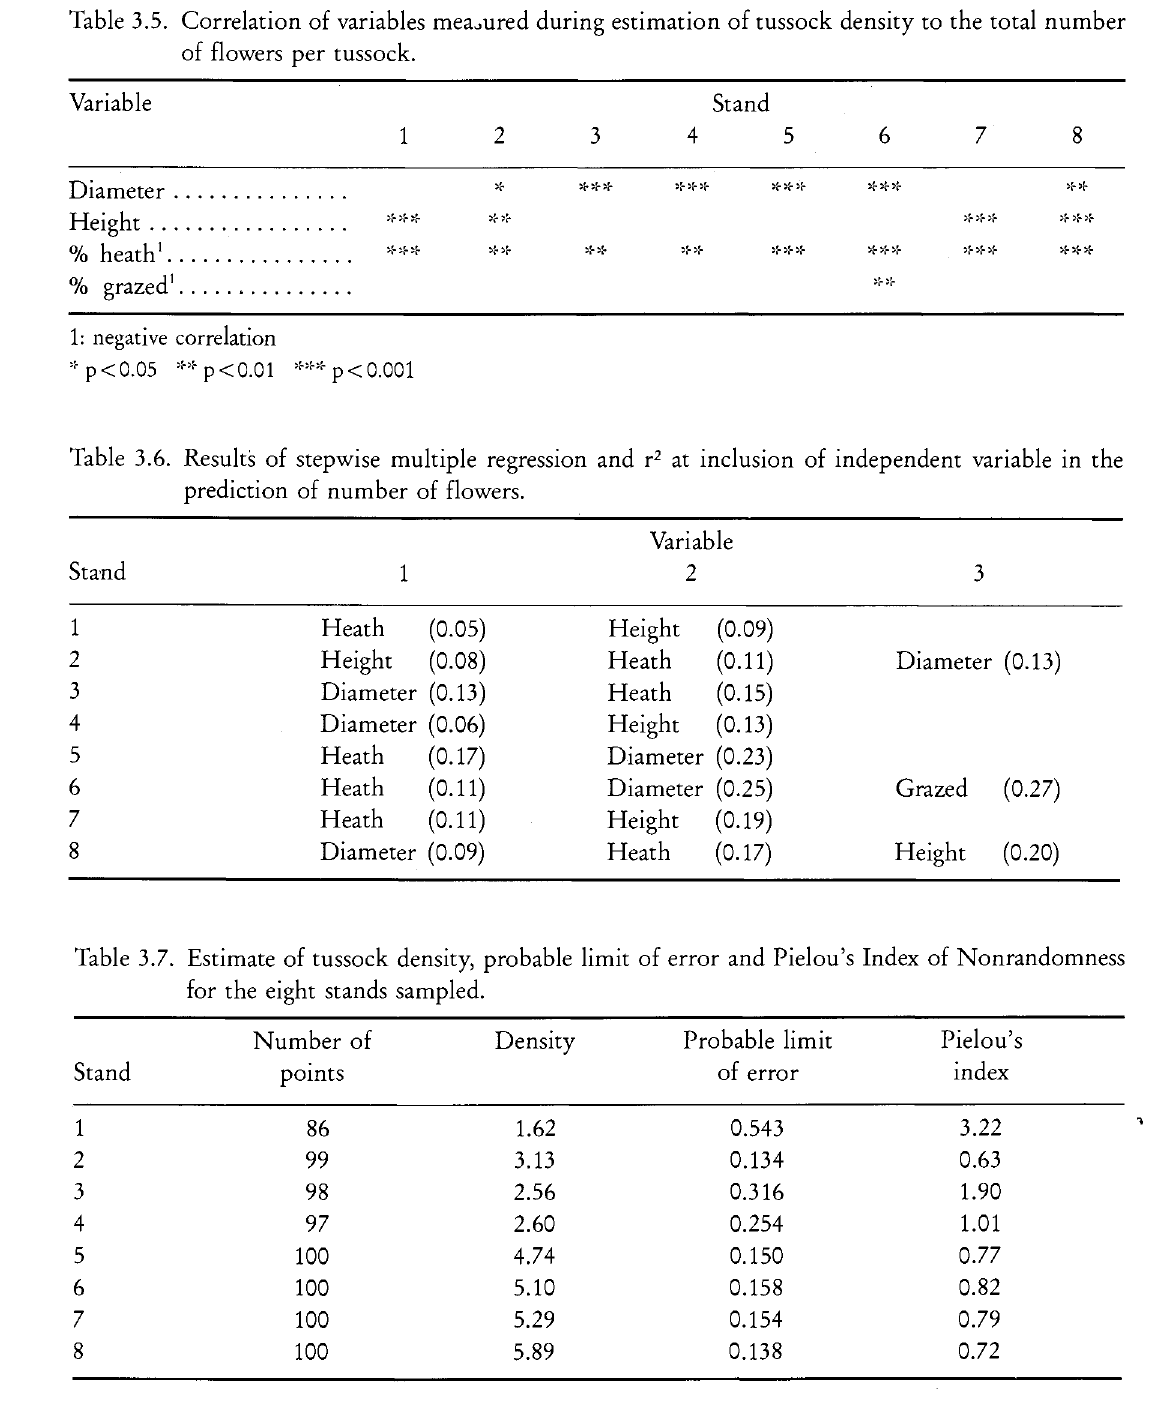
Table 3.7. Estimate of tussock density, probable limit of error and Pielou's Index of Nonrandomness for the eight stands